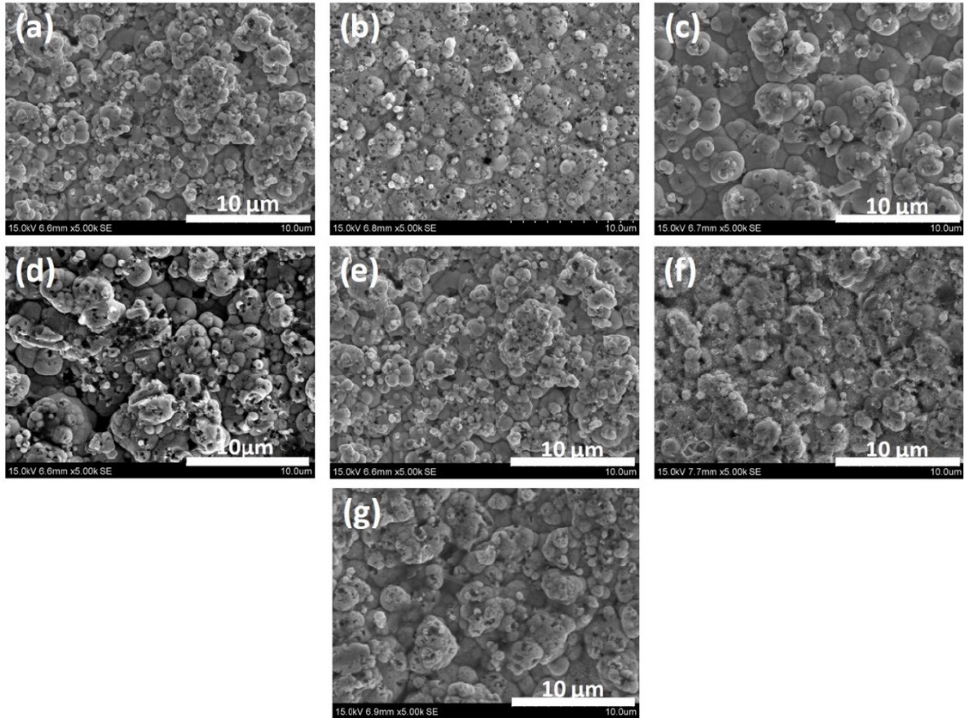
Figure 1. SEM images of the Ni-W/B composite coatings obtained at 75 °C, 5 g/L boron concentration, 0.1 A/cm 2 current density and 8.9 pH and various heat treatment temperatures ( a ) as-deposited,